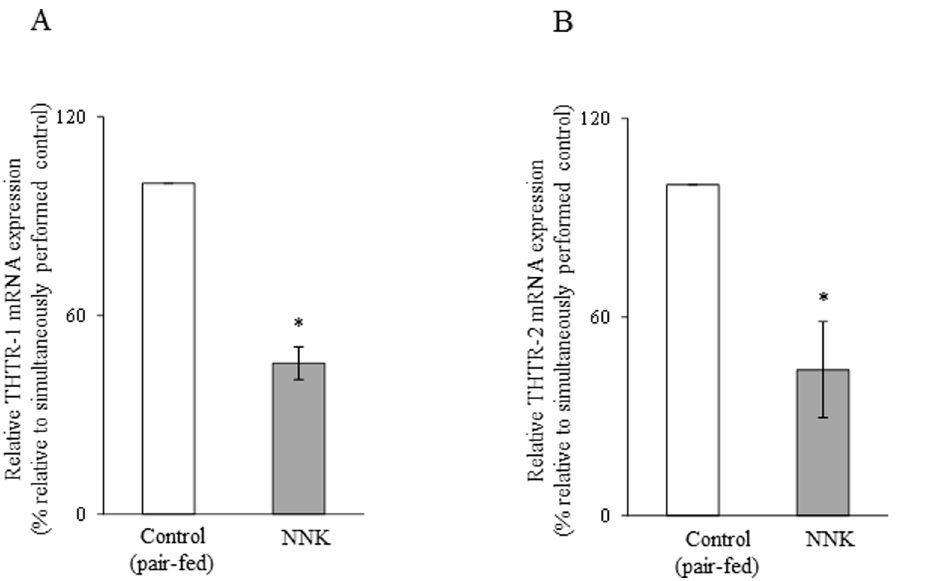
Figure 7. Effect of chronic exposure of mice to NNK on the level of expression of THTR-1 and THTR-2 mRNA in pancreatic acinar cells. QPCR was performed using mice THTR-1 (A) and THTR-2 (B) gene-specific primers and cDNA prepared from pancreatic acinar RNA of NNK- treated mice and their pair-fed controls. Data are mean 6 SE from separate sets of samples from multiple mice and were normalized relative to ARPO and calculated by the relative relationship. * P , 0.01.